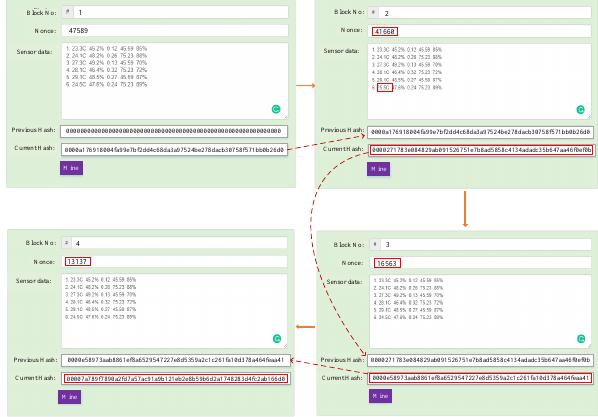
Figure 13. The result when we revise each block